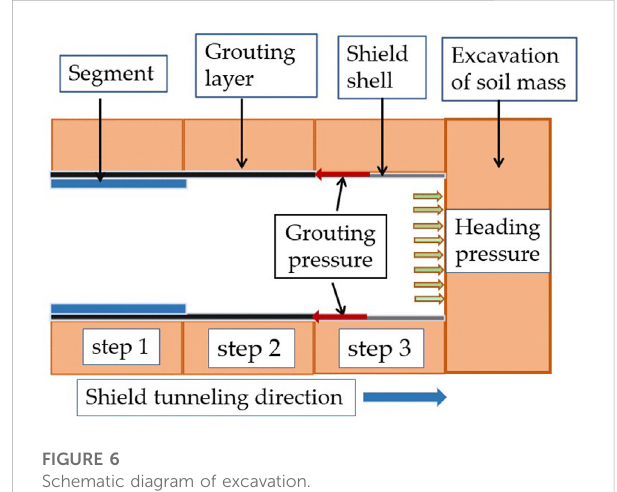
FIGURE 6 Schematic diagram of excavation.